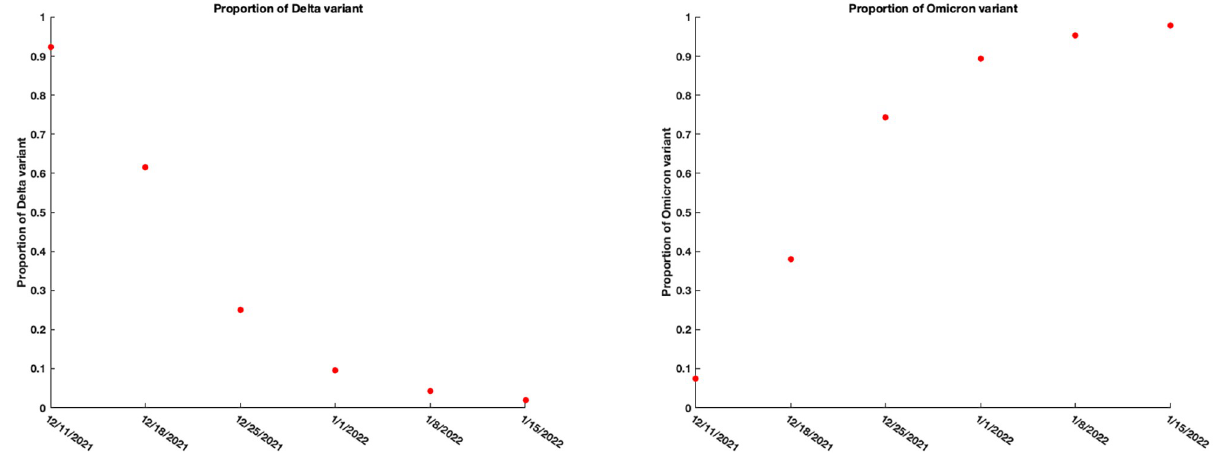
Fig 12. Proportion of the Delta (a) and the Omicron (b) variant for the period 12.11.2021 to 01.15.2022 in the United States collected from CDC2.